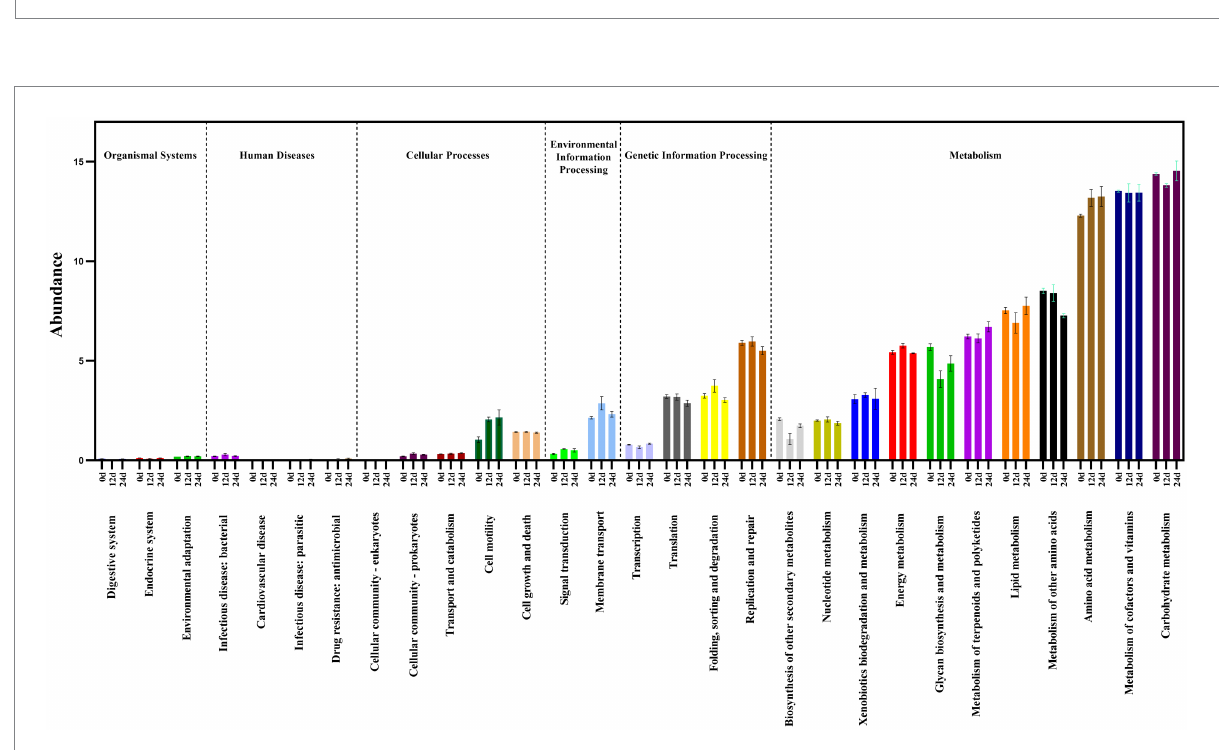
followed by protein degradation. We used online annotation tools 4 for analysis of published genomic data on the black soldier fly (Zhan et al., 2020; Generalovic et al., 2021). We plotted black soldier fly pathways of protein digestion and